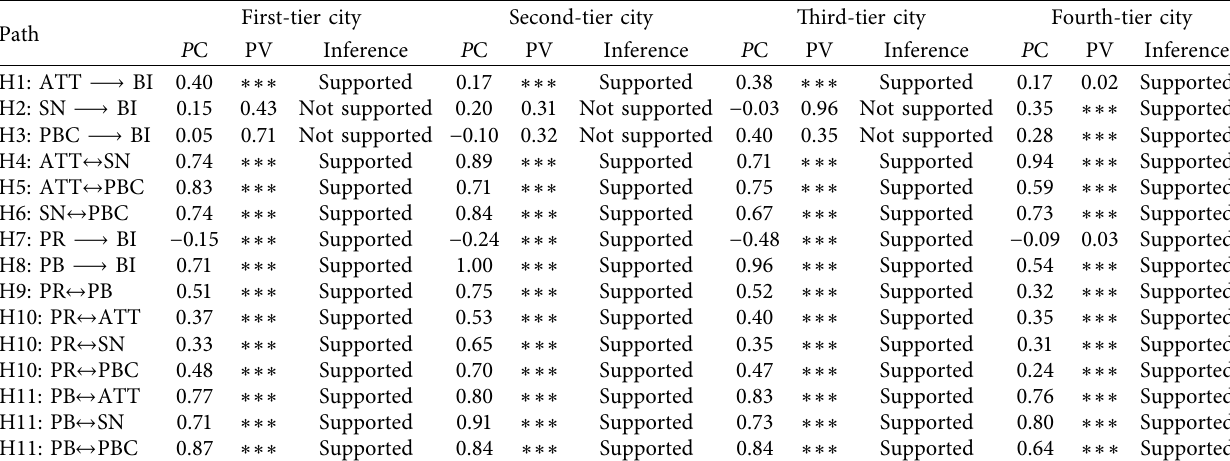
Table 6: Test results of the proposed hypotheses.